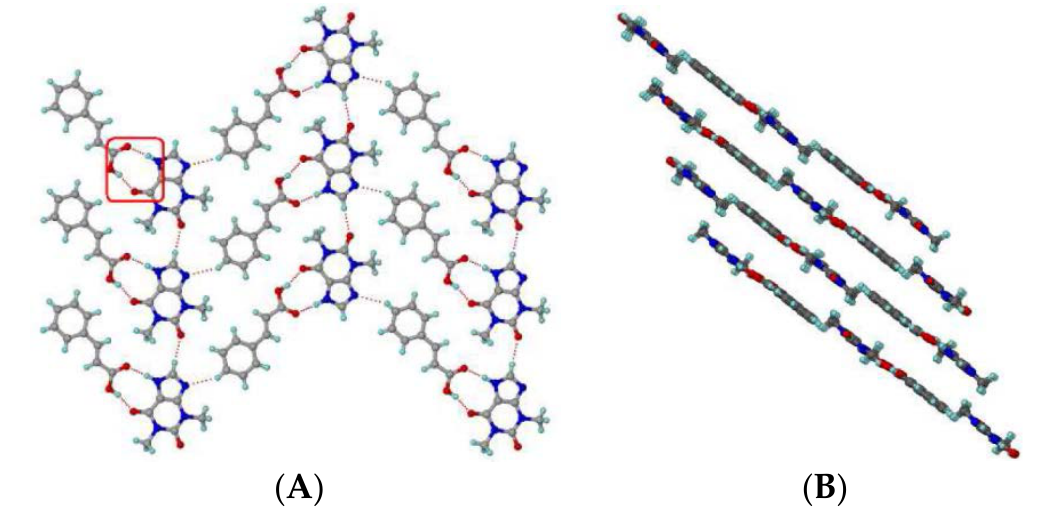
Figure 14. ( A ) 1D zig-zag chain arrangement brought about by 2-point acid...amide synthon through formation of O-H...O and N-H...O hydrogen bonds in theophylline-cinnamic acid (1:1) cocrystal, ( B ) Stacking of 2D layers by weak interactions completes the 3D arrangement [Reprinted from [240] with permission. Copyright 2014 American Chemical Society].